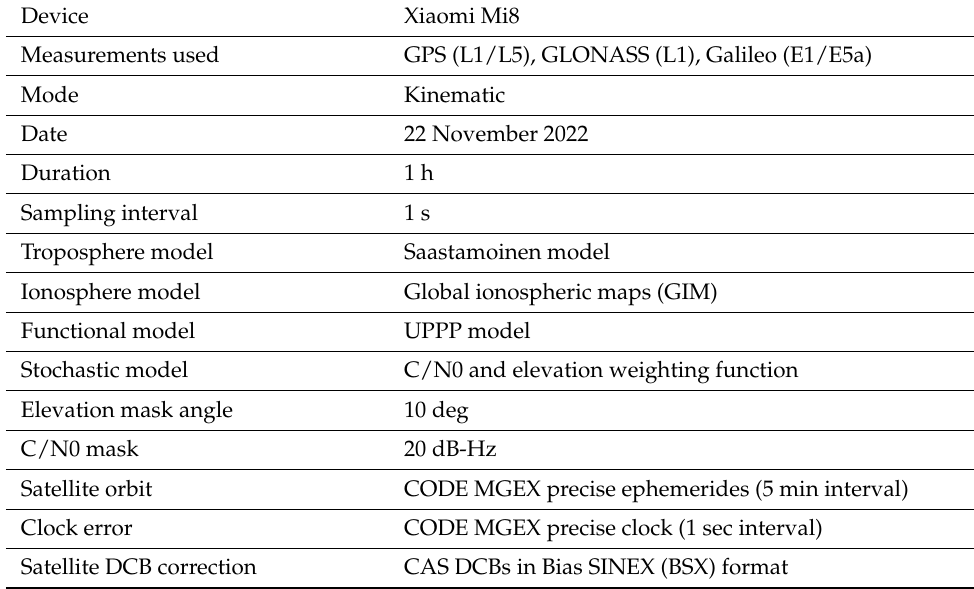
Table 5. GNSS data information and processing